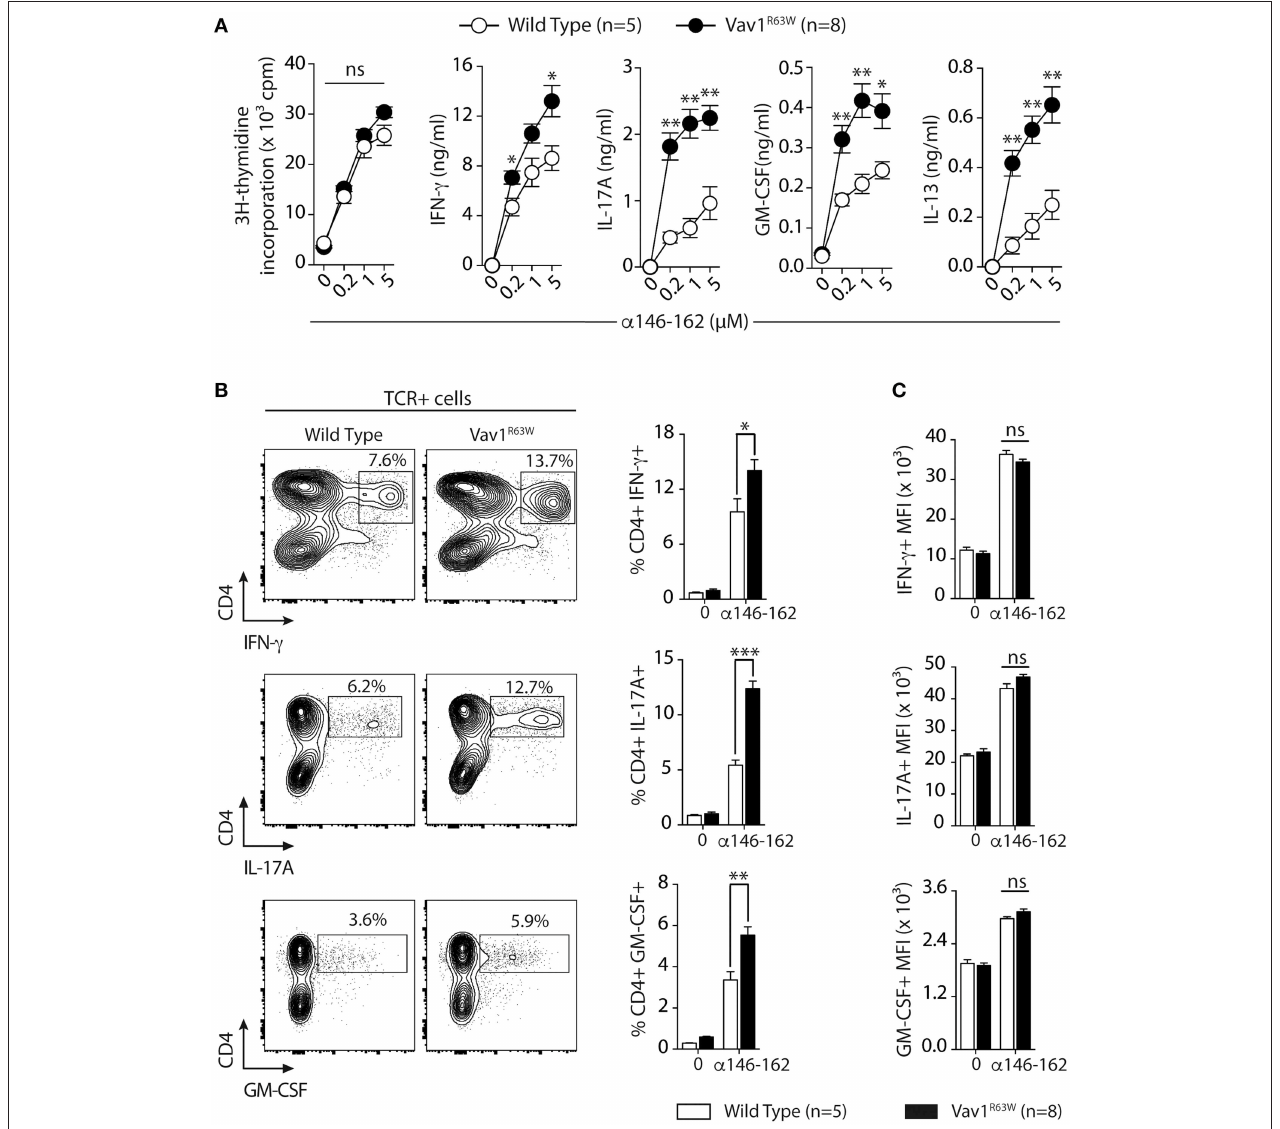
FIGURE 4 | Cytokine production and frequency of CD4T cell-producing cytokines after α 146-162 AChR peptide immunization of WT and Vav1 R63W mice. WT or Vav1 R63W mice were immunized with 50 µ g of α 146-162 AChR peptide. Draining LN cells were harvested 9 days later and stimulated for 48h with increasing concentrations of α 146-162 AChR peptide. Cytokine secretion was quantified by ELISA and CBA kit in the supernatants (A) . The frequency of TCR + CD4 + LN cells producing cytokines was determined by intracytoplasmic staining after 72h stimulation without or with α 146-162 AChR peptide (1 µ M) (B) . The intensity of expression of each cytokine by TCR + CD4 + LN cells was quantified by the Mean Fluorescence Intensity (MFI) (C) . Data represent a pool of 2 independent experiments. Mann-Whitney test, ns, non-significant; * P < 0.05; ** P < 0.01; *** P <